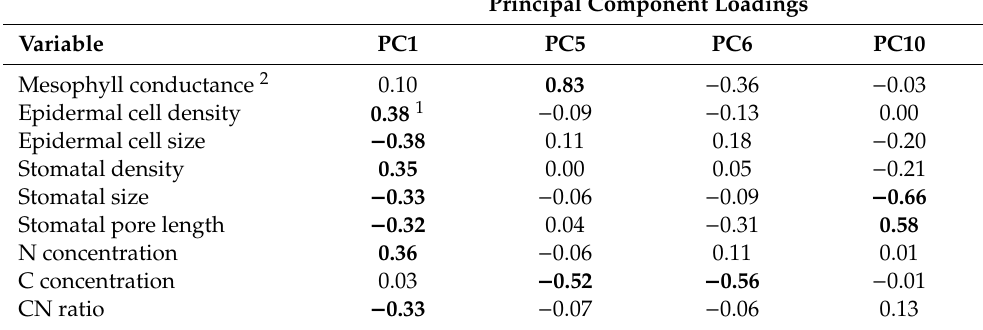
Table 3. Loadings for each variable used to predict physiological parameters V Cmax and J max , for each principal component (P1–13) that was a significant explanatory variable in either of the best fit multiple regression models.